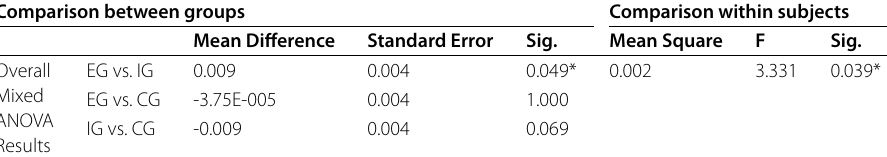
Table 2 Mixed ANOVA for self-mentions (normalized values) Comparison between